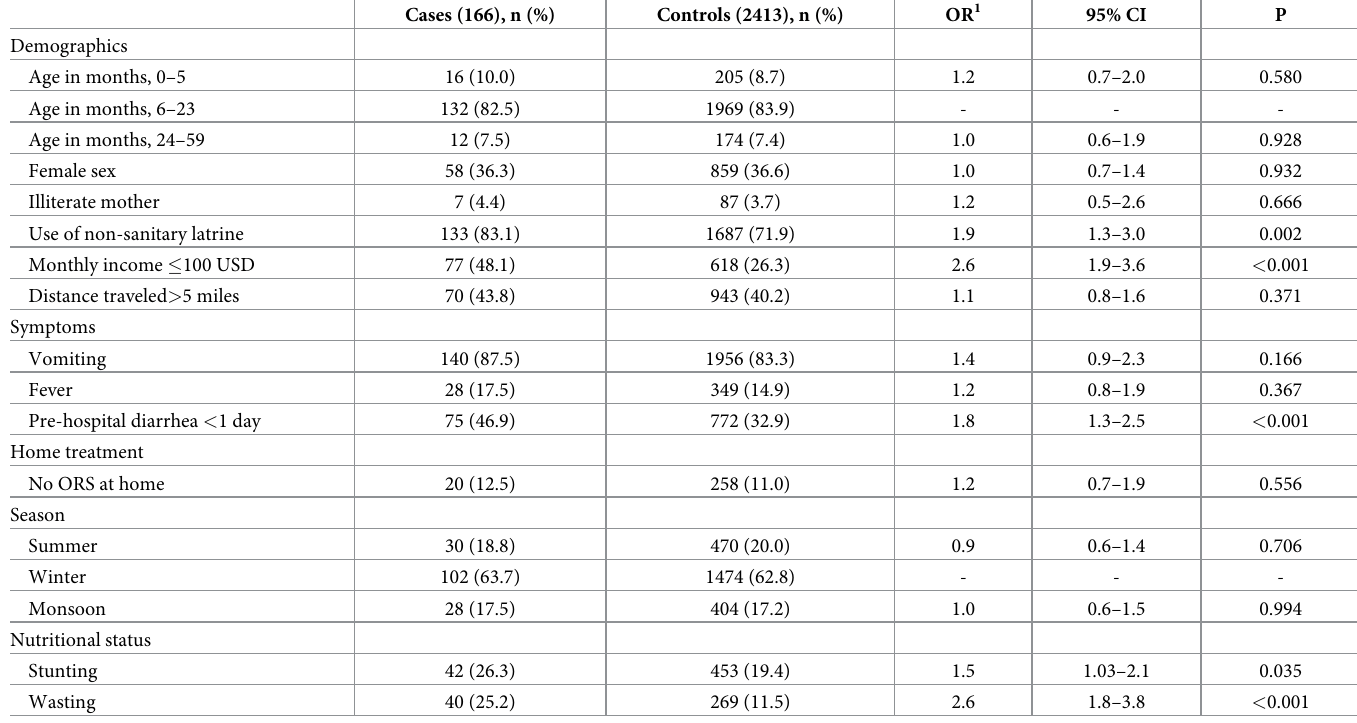
Table 2. Characteristics of rotavirus-infected under-five children with (cases) or without (controls) clinical dehydration in Matlab. Cases (166), n